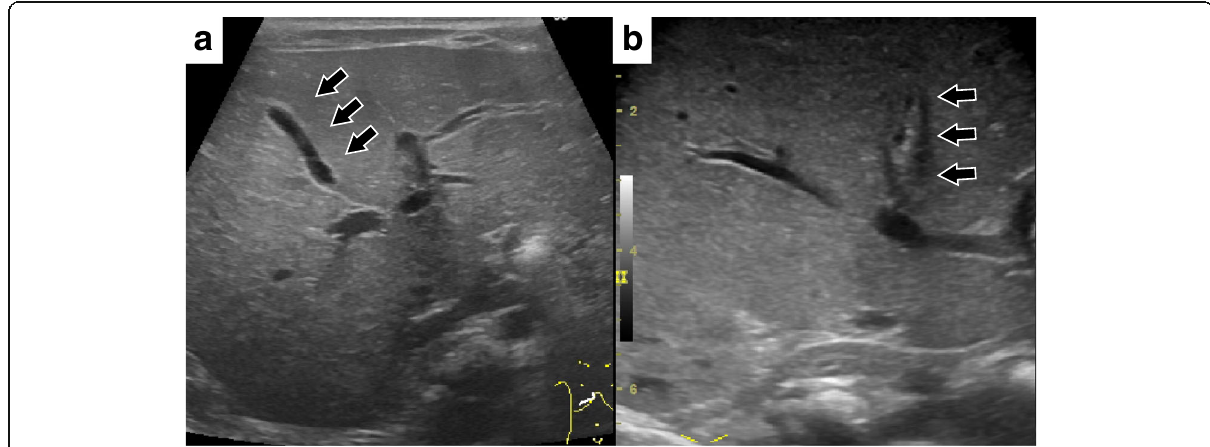
Fig. 1 Preoperative abdominal ultrasonography. a Six hours after oral feeding. A gallbladder with a diameter of 19 mm was isolated. b The gallbladder contracted 1.5 h after oral feeding